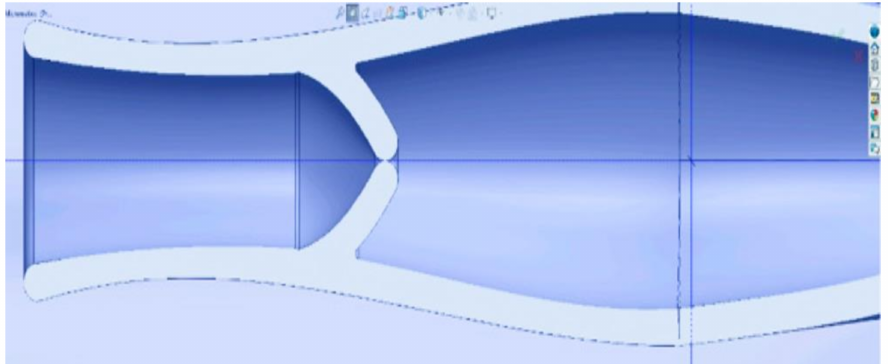
Figure 3. Wireframe model section with a close-up of the lymphatic vessel with a valve similar to the original to prevent the return of lymph